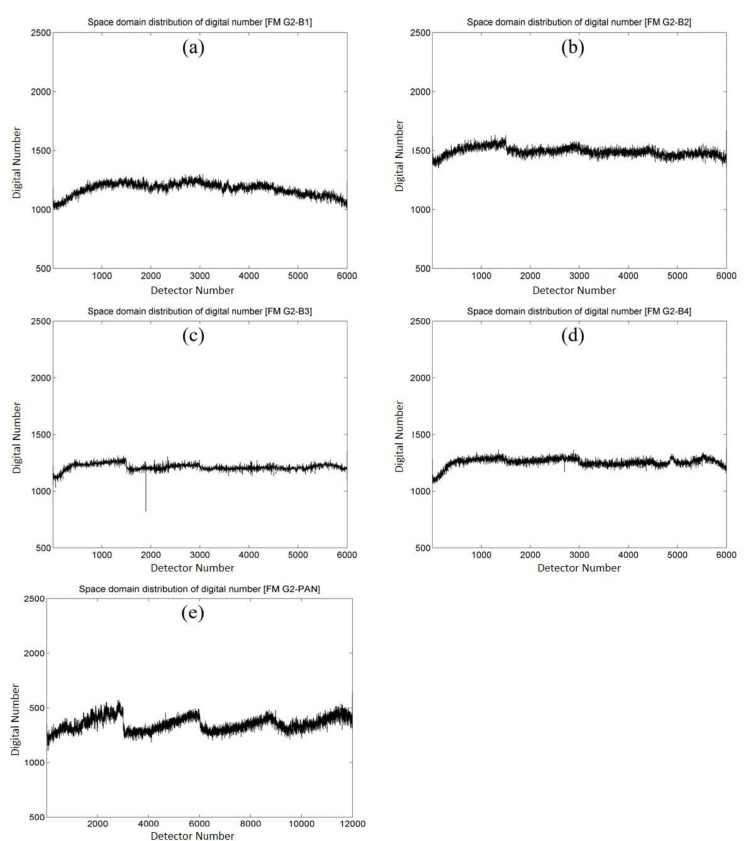
Figure 7. Spatial non-uniformity of grayscale values (digital numbers) from flying mode test imagery for all bands of gain setting G2. ( a ) Band 1 (blue band); ( b ) Band 2 (green band); ( c ) Band 3 (red band); ( d ) Band 4 (near infrared band); ( e ) PAN (panchromatic